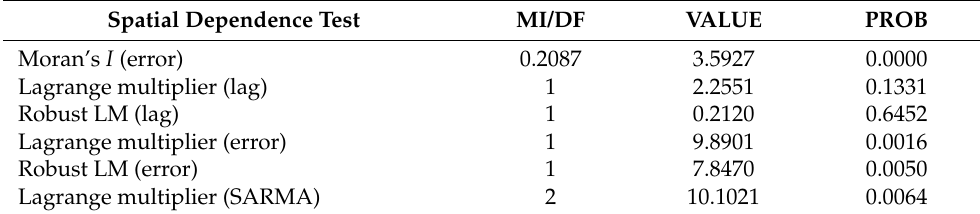
Table 4. Spatial dependence test of PLIU coordinated development.